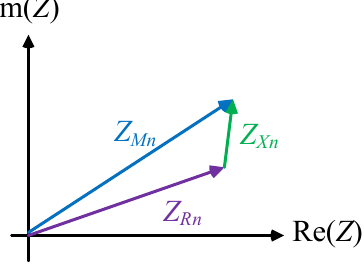
Figure 2. The relations between impedances Z Mn , Z Rn and Z Xn